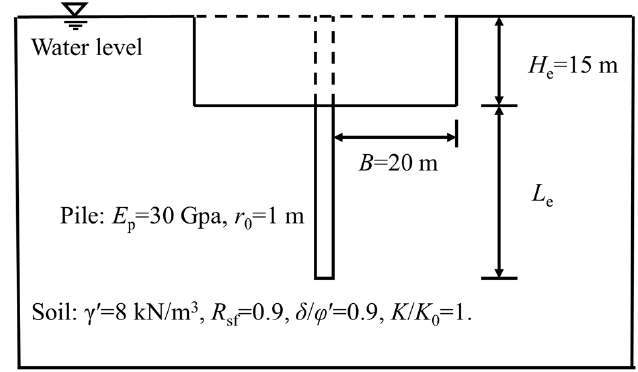
Figure 12. Calculation model for the parametric study.